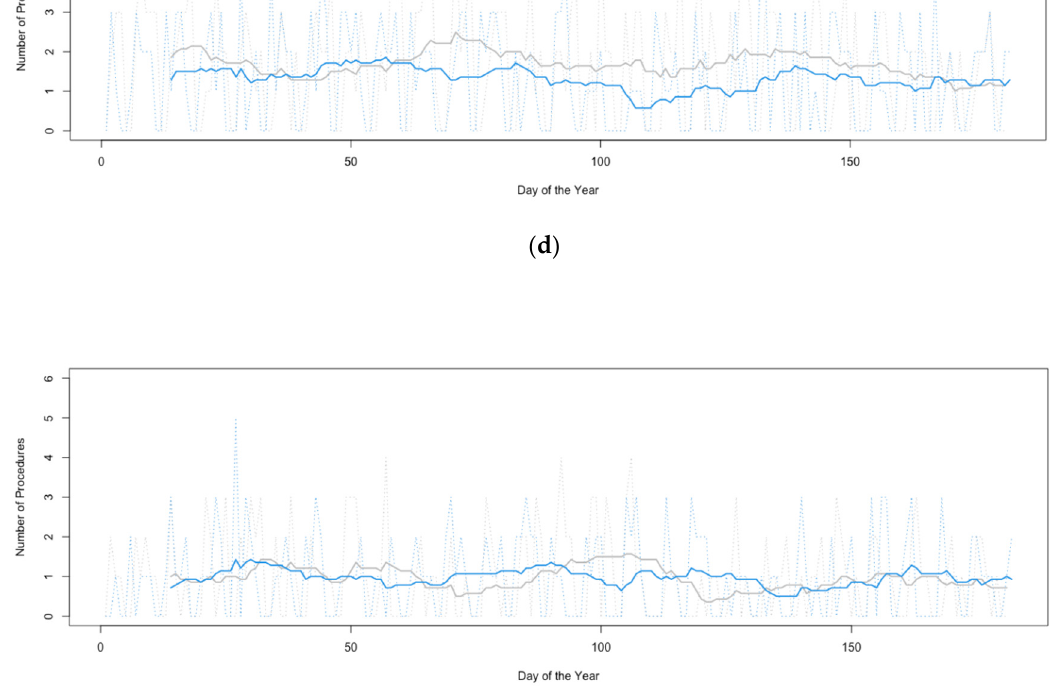
Figure 1. ( a ). Novel coronavirus-positive case numbers in Germany as published by the Robert Koch Institute (RKI) from 4 March 2020 (absolute values; black, dashed). Exponential (red) and arc tangent (ATC; orange) curves were manually fitted to the RKI data; the formulas of the fitted curves are given in the methods section of this paper (Formulas (1) and (2)). ( b ). Daily outpatient numbers (ON; grey, dotted) and moving averages thereof (MAON; grey) in the first half of 2019 as compared to daily ON (blue, dotted) and MAON (blue) in the first half of 2020. ON were significantly decreased in April 2020 as compared to April 2019 ( p = 0.010, Table 1). Numbers of appointments cancelled between 16 March 2020 and 15 May 2020 explicitly due to the coronavirus 19 disease (COVID-19) pandemic (pink, dotted), and moving averages thereof (pink). Lockdown in Germany due to the COVID-19 pandemic on 16 March 2020 (green). The derivative function of the ATC from Figure 1a (DFATC; orange, dashed; Formula (3) given in the methods section of this paper) was significantly negatively correlated ( rho = − 0.92, p < 0.0001) to the MAON from 1 February 2020 until 31 March 2020, and, when shifted by 10 days (orange), the DFATC was significantly negatively correlated to the MAON from 1 April 2020 until 30 June 2020 ( rho = − 0.87, p < 0.0001). To allow for a better comparison with the 2020 MAON, the DFATC was flipped upside down with its baseline and its ordinate extension adjusted. ( c ). Daily neurosurgical elective procedures (EP; grey, dotted) and moving averages thereof (grey) in the first half of 2019 as compared to daily EP (blue, dotted) and moving averages thereof (blue) in the first half of 2020. EP were significantly less performed ( p = 0.023, Table 1) in the first half of 2020 as compared to the first half of 2019. ( d ). Daily neurosurgical non-oncological elective procedures (NEP; grey, dotted) and moving averages thereof (grey) in the first half of 2019 as compared to daily NEP (blue, dotted) and moving averages thereof (blue) in the first half of 2020. NEP were significantly less performed ( p = 0.032, Table 1) in the first half of 2020 as compared to the first half of 2019. ( e ). Daily neurosurgical oncological elective procedures (OEP; grey, dotted) and moving averages thereof (grey) in the first half of 2019 as compared to daily OEP (blue, dotted) and moving averages thereof (blue) in the first half of 2020. Significant di ff erences in frequencies of OEP between the first halves of both years were not